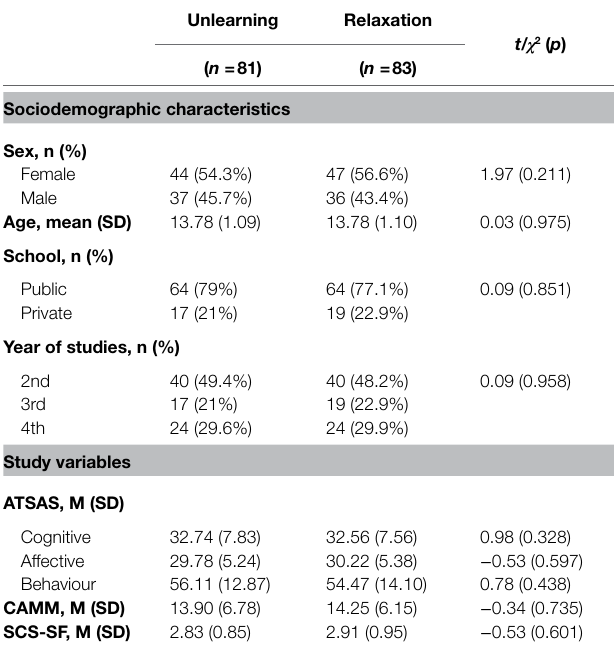
TABLE 1 | Sociodemographic characteristics of the sample and baseline levels of nonviolence, mindfulness and compassion. Unlearning